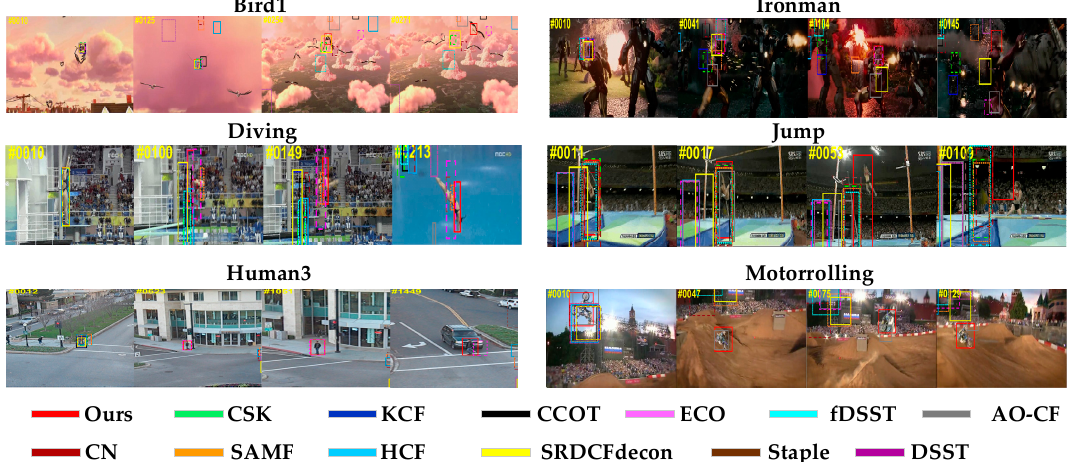
Figure 10. Qualitative evaluation of six video sequences (i.e., Bird1, Ironman, Diving, Jump, Human3, and Motorrolling). We show the results of ours and the other 12 trackers, including nine HFTs and three DFTs with different colors (our results are in red).